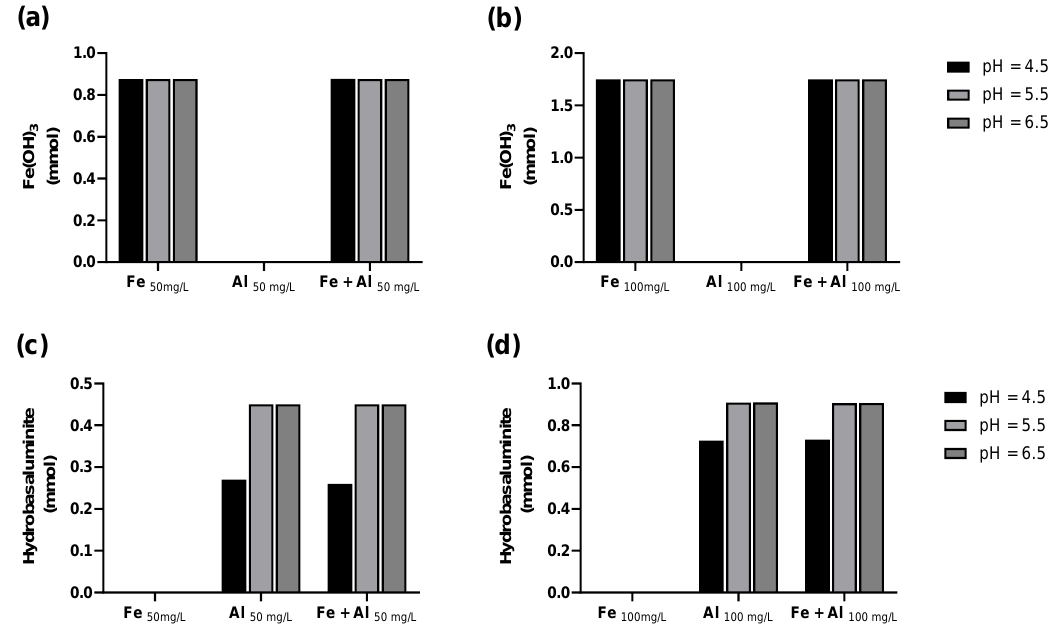
Figure 3. Iron and aluminum mineral phases precipitated according to geochemical simulations. ( a , b ) Amorphous Fe(OH) 3 precipitated equally at the three pH levels studied in iron and mixed solutions; ( c , d ) Hydrobasaluminite precipitation was lower at pH = 4.5, precipitating at the same levels in aluminum and mixed solutions.